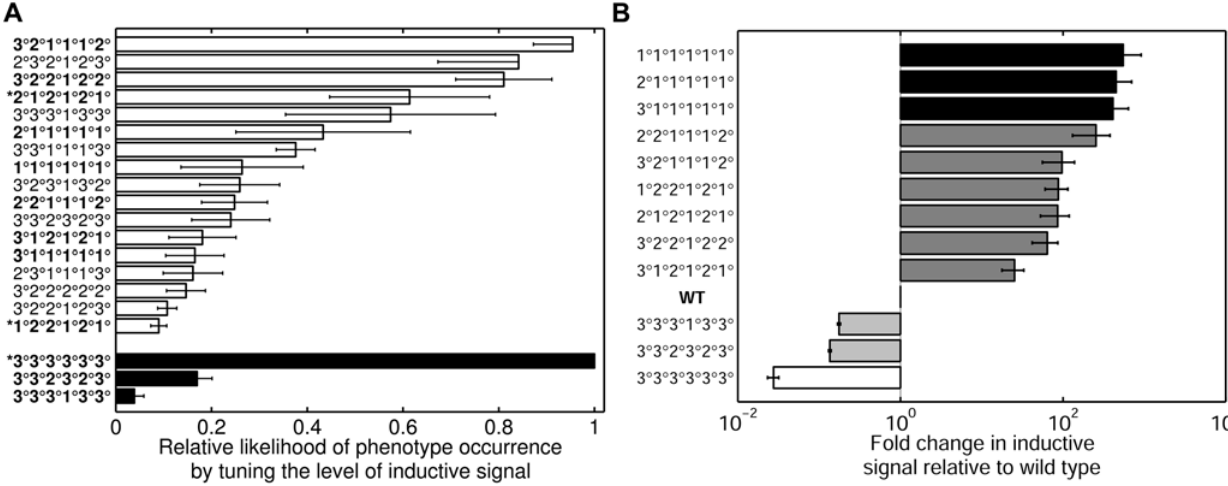
Figure 5. The hierarchy of phenotypes predicted to occur through quantitative changes in morphogen level. (A) The relative probability ( x -axis) of reaching different mutant phenotypes ( y -axis) upon decreasing (filled bars) or increasing (open bars) the amount of LIN-3 morphogen. The predicted phenotypes denoted with an asterisk are ones observed experimentally in C. elegans . Bold-faced phenotypes correspond to multicellular patterns observed experimentally in the three major species of the Caenorhabditis genus (see Figure 6A). (B) The predicted fold change in inductive signal ( x -axis) necessary to convert the wild-type phenotype into underinduced phenotypes (Fold change , 1) and over-induced phenotypes (Fold change . 1). The phenotypes listed on the y -axis correspond to the bold-faced phenotypes in panel (A). The list has been re-sorted according to the required fold change in inductive signal. The shading of bars corresponds to the shading of experimentally observed phenotypes in Figure 6A.